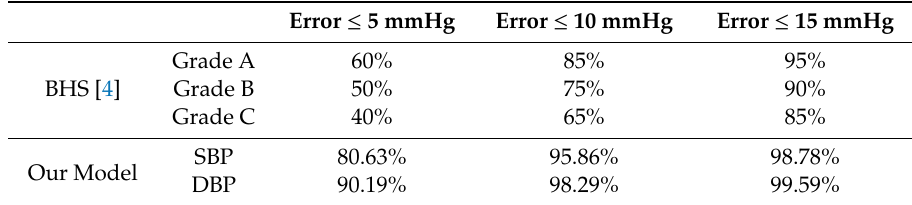
Table 2. The standards of the British Hypertension Society (BHS) for BP measuring devices and the performance of our model.